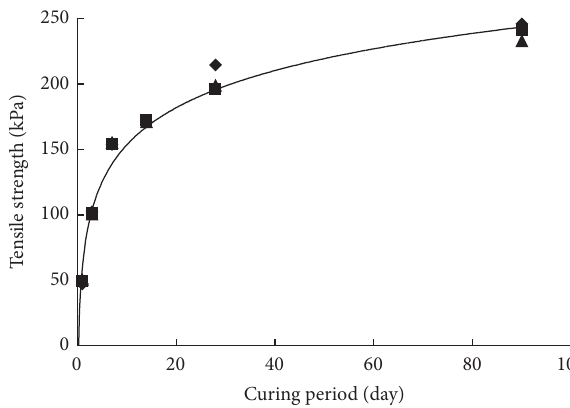
Figure 7: Relationship of ratio of tensile strength/unconfined compressive strength-curing